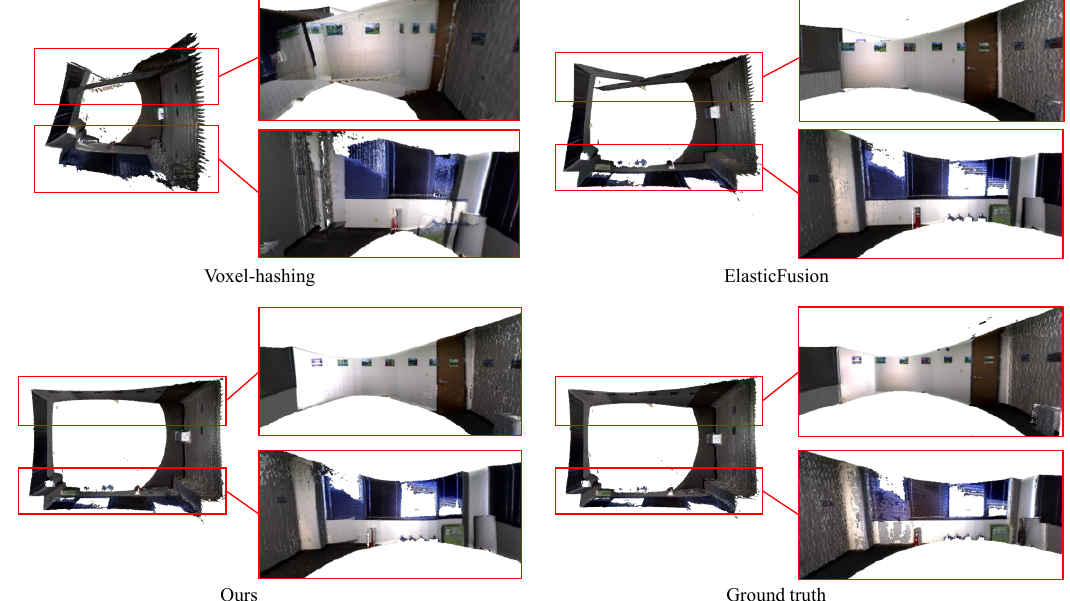
Fig. 7 Reconstruction results for different methods on room data captured by a speed-controlled fast-moving